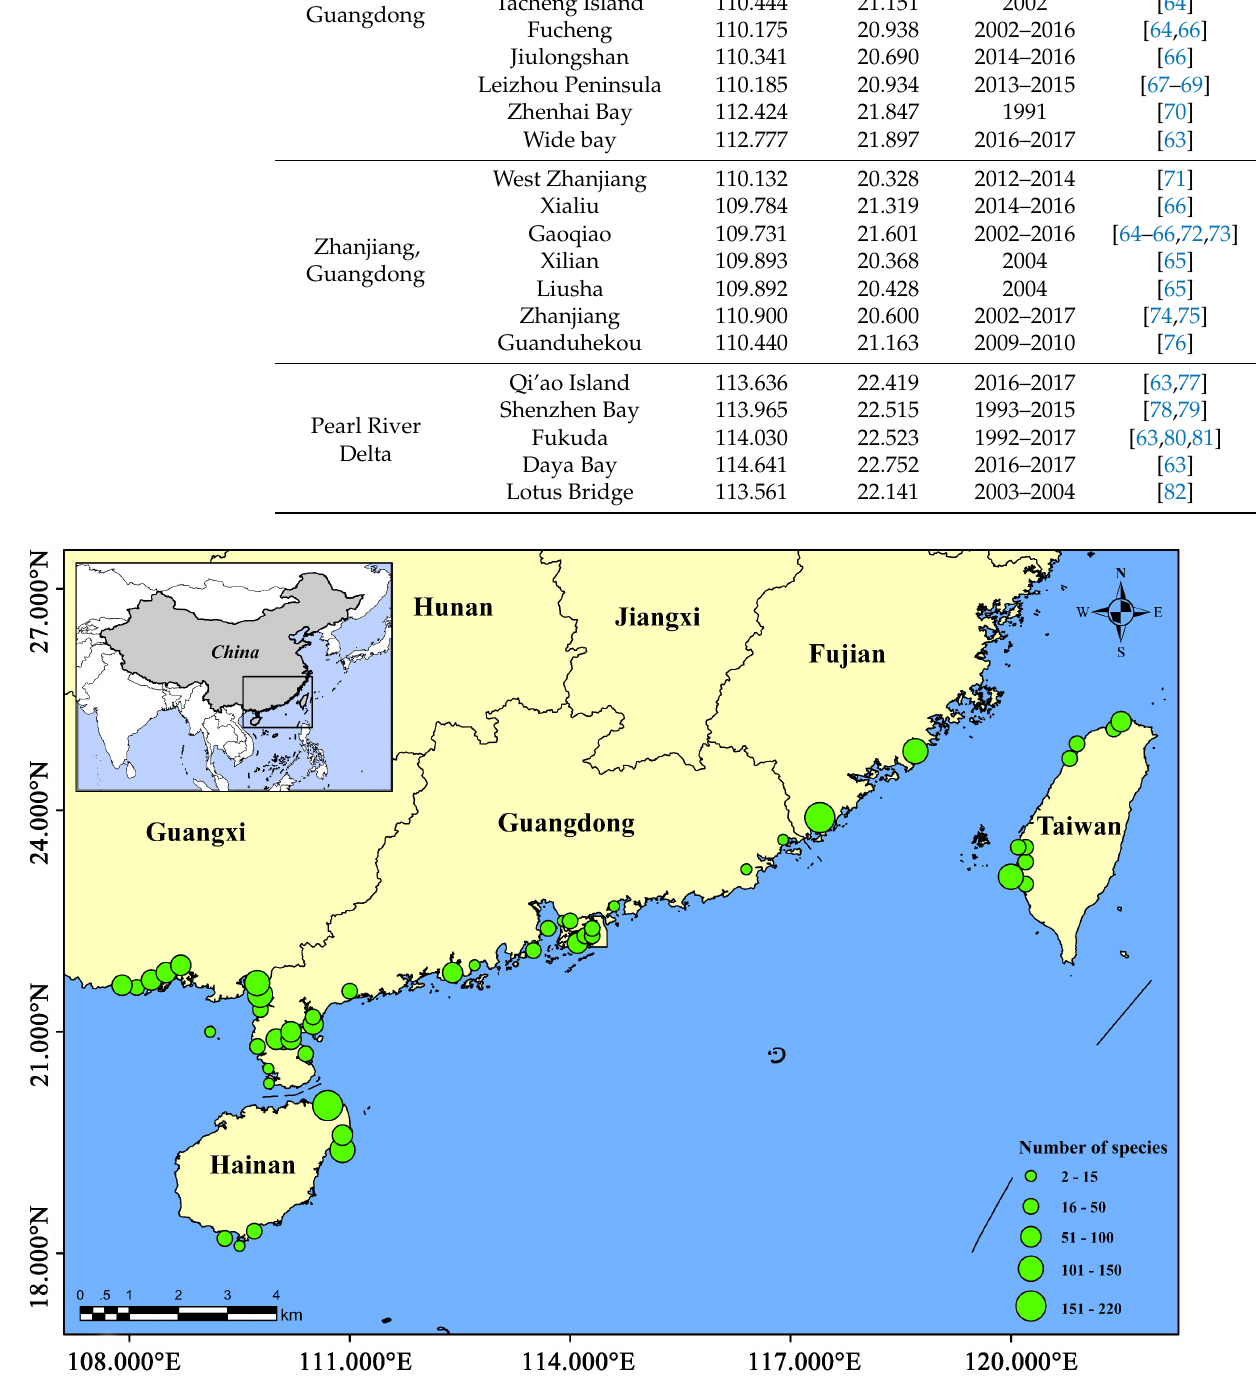
Figure 1. Distribution of fish populations in different study areas. The green circle in the figure is the number of fish